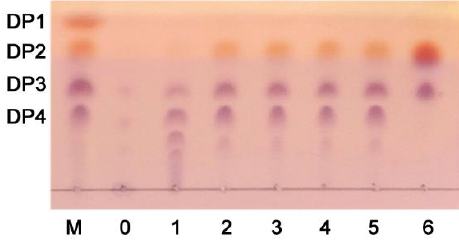
Figure 5. Thin-layer chromatography (TLC) analysis of chitosanase-hydrolytic products. Lane M: standard chitosan oligomers (GlN, DP1–4); Lanes 0–6: enzymatic hydrolysates of chitosan incubated at 30 °C for 0, 1, 10, 30, 120, 360 and 1440 min, respectively.